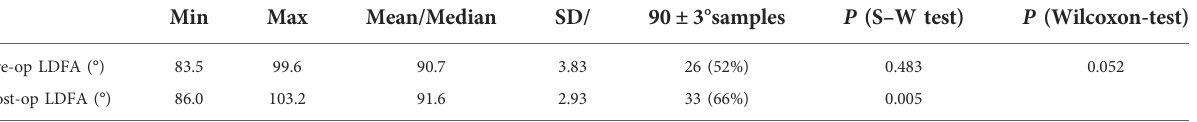
TABLE 3 Pre-operation and post-operation LDFA comparison.